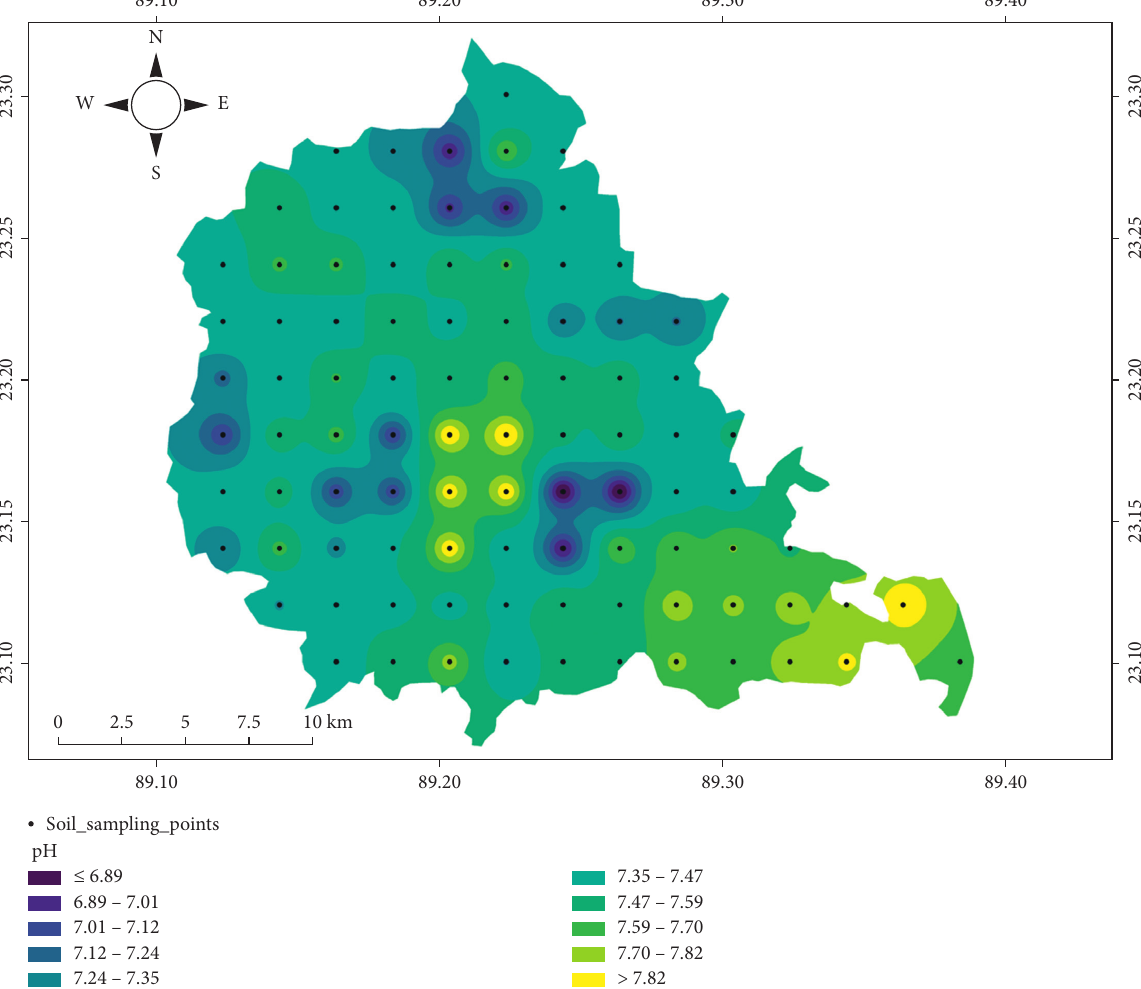
Figure 5: Spatial distribution of soil pH contents in the study